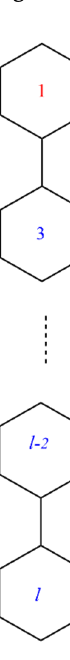
Figure 7. Graphene structure with 𝑙 = 1,𝑘 > 1 .